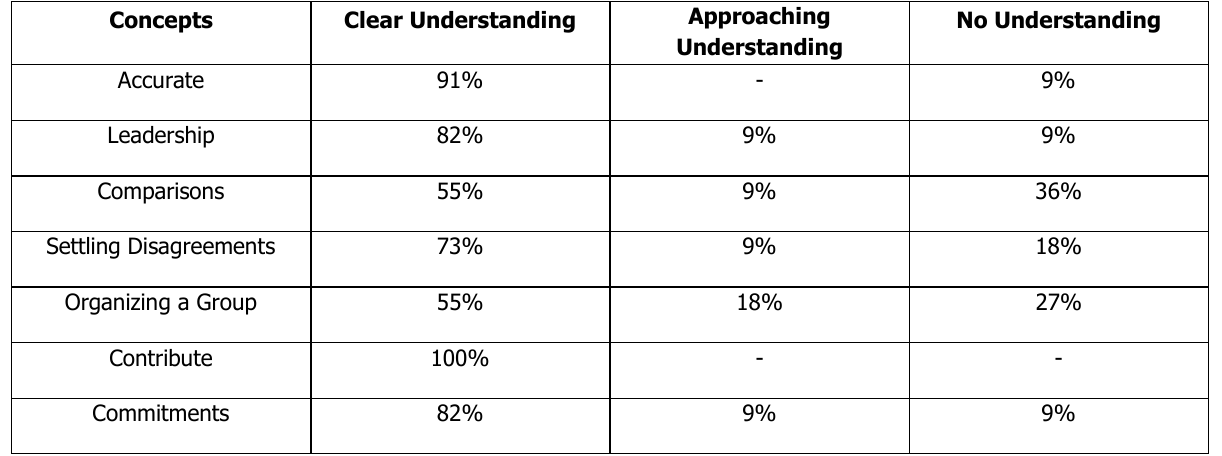
Percentage of Participants Understandings of